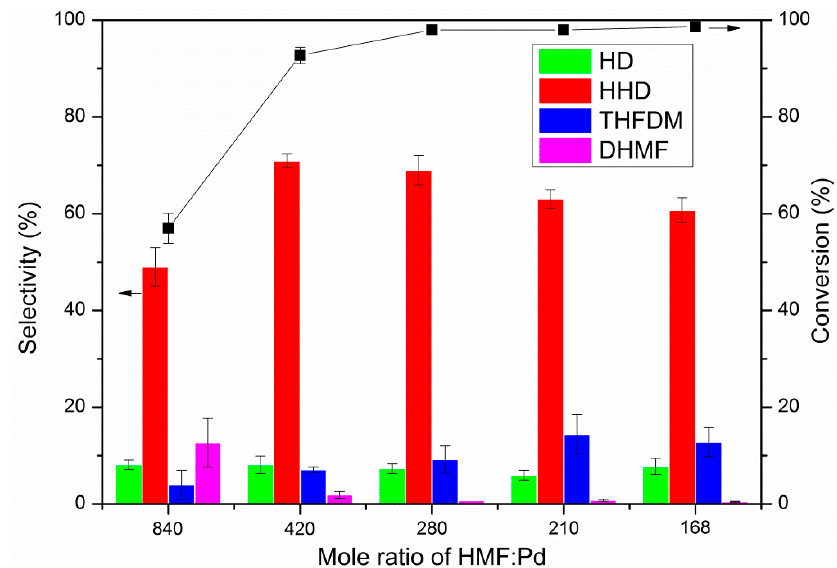
Figure 3. The e ff ect of mole ratio on the hydrogenation of HMF. Reaction conditions: Pd / C (12.5 mg, mole ratio, HMF / Pd = 420:1), HMF (2.5 mmol), AcOH (60.0 mg, 1 mmol), H 2 O (2.00 g), H 2 (4 MPa), 393 K, 3 h. The error bars refer to the confidence interval with 95% confidence.